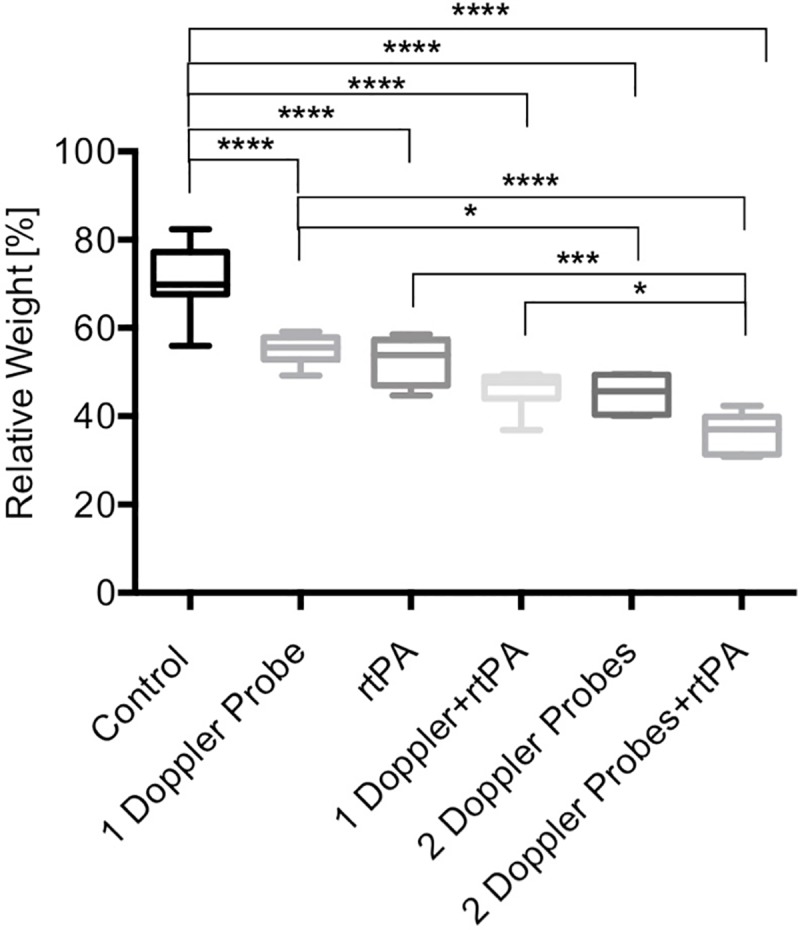
Comparison of spontaneous lysis, rtPA-induced lysis, sonothrombolysis with one and two Doppler probes and combined treatment.The box plots show the relative weight (y-axis) of the different groups (x-axis) after different treatments. ****p<0.0001, ***p = 0.0002, group 4 (1 Doppler+rtPA) versus group 6 (2 Doppler probes+rtPA) *p = 0.048, group 2 (1 Doppler probe) versus group 5 (2 Doppler probes) *p = 0.038.